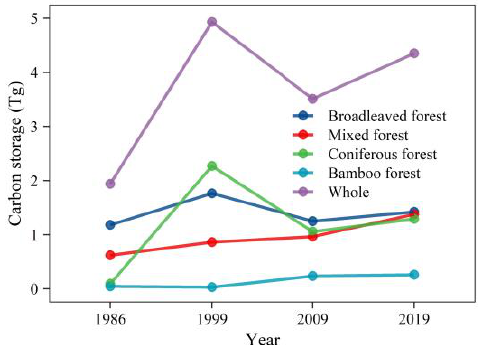
Figure 6. Vegetation carbon storage change in different forest types from 1986 to 2019.